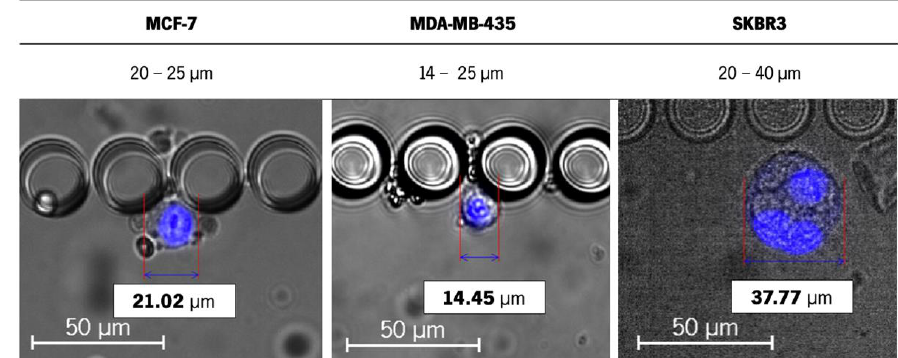
Figure 1. Representative image of cells of three different cell lines trapped inside the RUBYchip™ at the spiking assay. MCF-7, MDA-MB-435 and SKBR3 estimated sizes are 21.02, 14.45 and 37.77 μm, respectively. The images were acquired and observed with a 20× objective. The scale bars correspond to 50 μm.